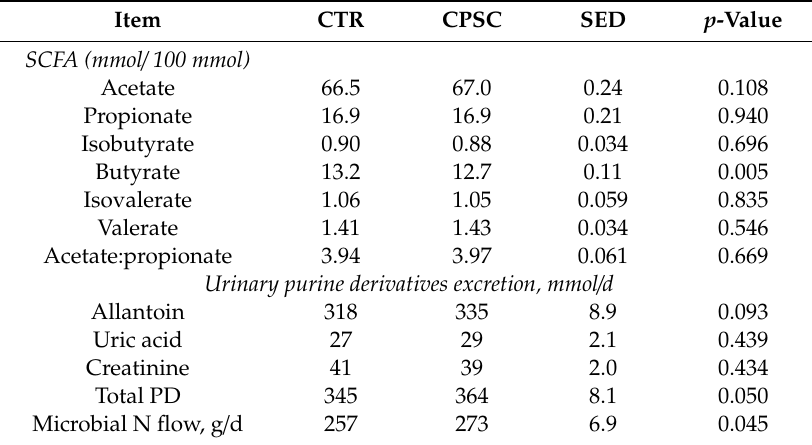
Table 4. E ff ect of feeding cold-pressed sunflower cake on ruminal fermentation and urinary purine derivative excretion (LSM, n = 10).